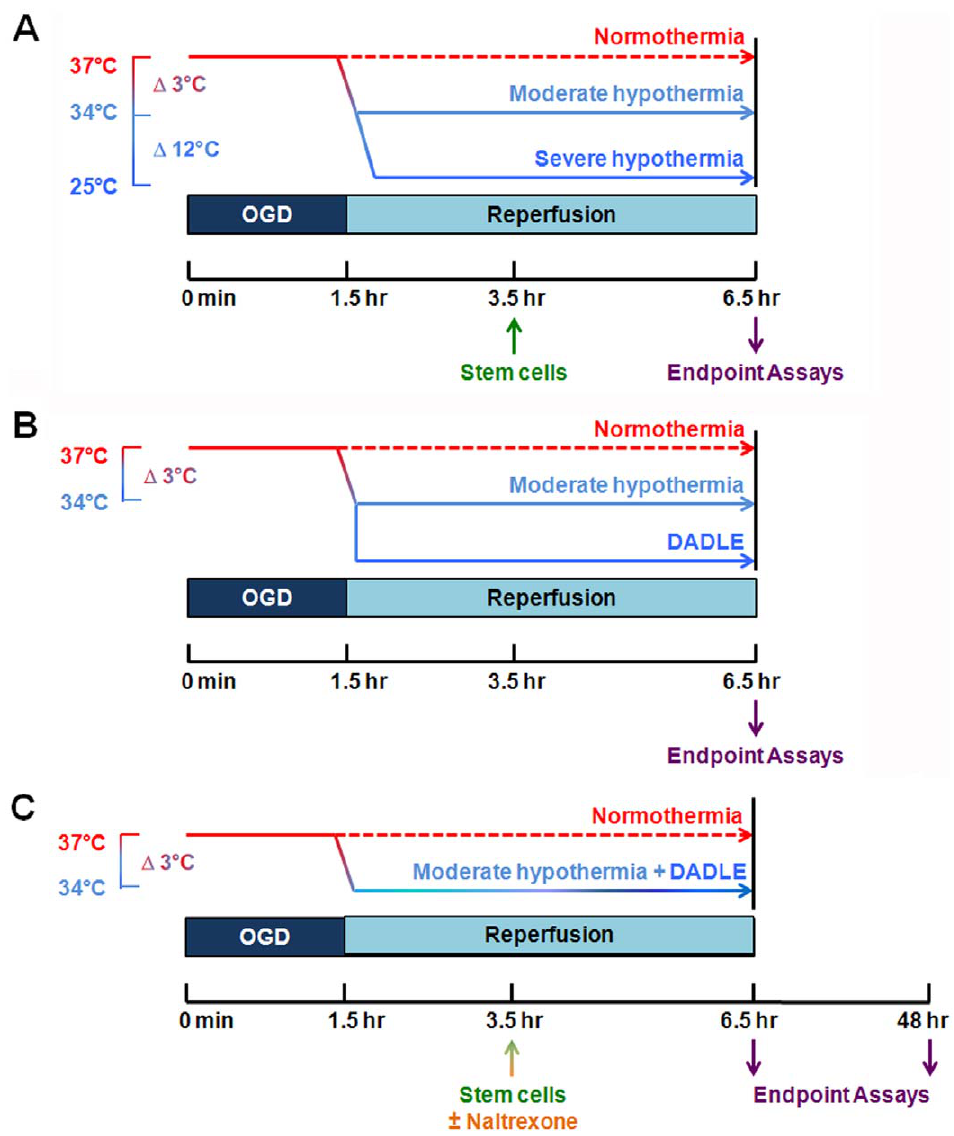
Figure 1. Experimental design. The diagram captures time course of temperature, introduction of stem cells, evaluation of cell viability and mitochondrial activity under different treatment conditions.